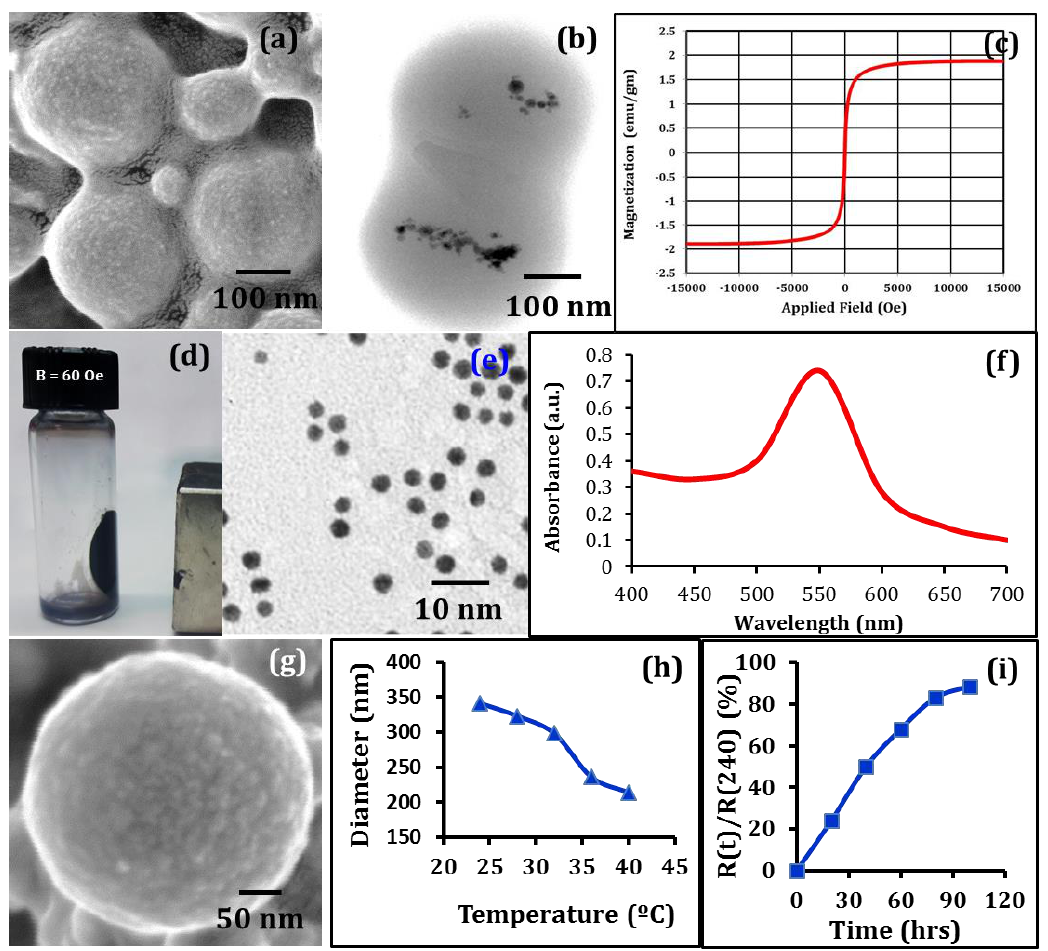
Figure 2. Morphology of designed CSMNSs: ( a ) SEM analysis demonstrating the polymer shell, and ( b ) TEM analysis demonstrating the distribution of the encapsulated MNPs. ( c ) Applied field vs magnetization plot for CSMNSs at 311 K, demonstrating super-paramagnetic behavior, even at the collapsed state of the polymeric shell. ( d ) Response of the CSMNSs to an applied DC magnetic field of 60 Oe by a permanent magnet at the adjacent wall of the flask. Characterization of the AuNPs: ( e ) TEM analysis demonstrating the particle distribution in cell culture media, ruling out the possibility of agglomeration, and ( f ) UV-visible spectrum of the dispersed AuNPs in the culture media. ( g ) SEM imaging of the CPNP demonstrating nanocarrier morphology. ( h ) Temperature dependence of hydrodynamic diameter of the CPNPs. ( i ) Drug release profile from the CPNPs. R(t) represents the mass released at any time t, and R(240) represents total mass released over 240 h (10 days).